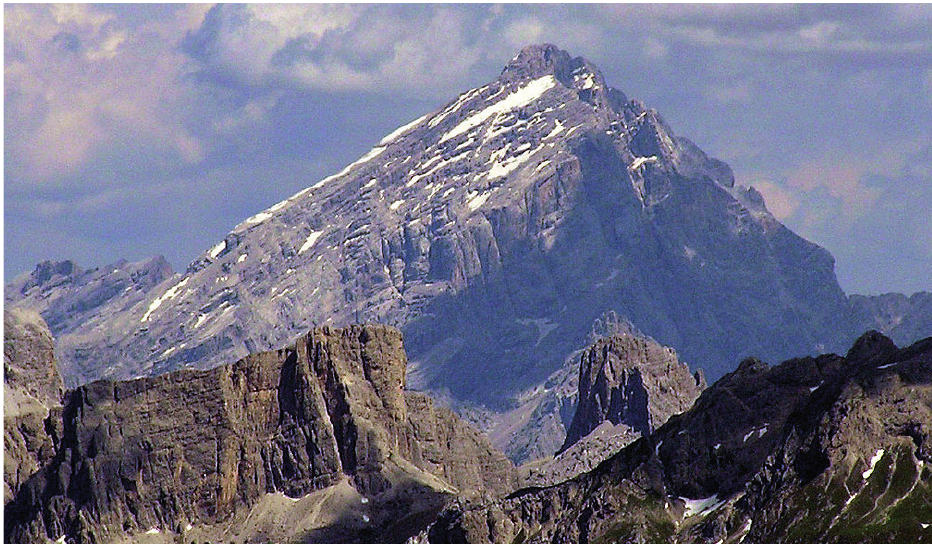
Figure 1. Mount Antelao in the Dolomites, as seen from the town of S. Vito di Cadore (from Wikipedia). Bottom left: Figure 2. May 2011 cover of The Economist, showing the increasing attention that the public is paying to the Anthropocene. The involvement of public opinion provides an important contribution to the debate, although sometimes it can obscure or twist the scientific evidence. Bottom right: Figure 3. Front cover of the 2009 Royal Society Report on ‘Geoengineering the